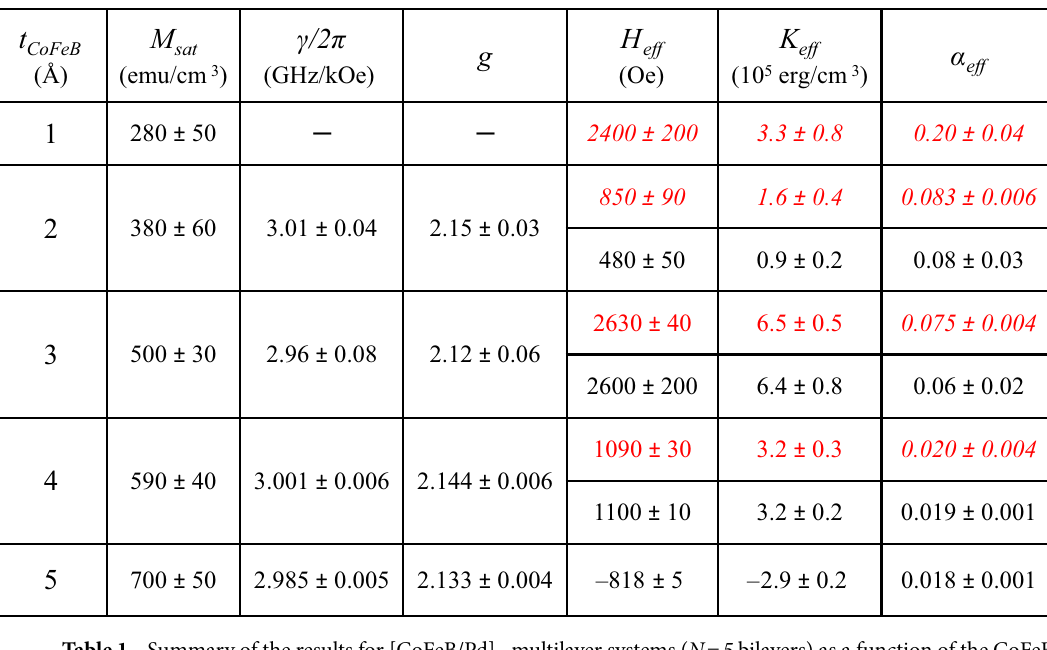
Table 1. Summary of the results for [CoFeB/Pd] N multilayer systems ( N = 5 bilayers) as a function of the CoFeB thickness ( t CoFeB ): the saturation magnetization ( M sat ) extracted from VSM; the gyromagnetic ratio ( γ/2π ) and g-factor ( g ) determined from VNA-FMR fits using Eq. (4); Effective anisotropy field ( H eff ) determined from VNA-FMR (Eq. 4) and TR-MOKE (Eqs. 2, 3 and 5); Effective anisotropy energy ( K eff ) determined from Eq. (6); The effective damping ( α eff ) determined from VNA-FMR and TR-MOKE. Data extracted from the VNA-FMR measurements is shown in black. Data extracted from the TR-MOKE measurements is given in italics and red .